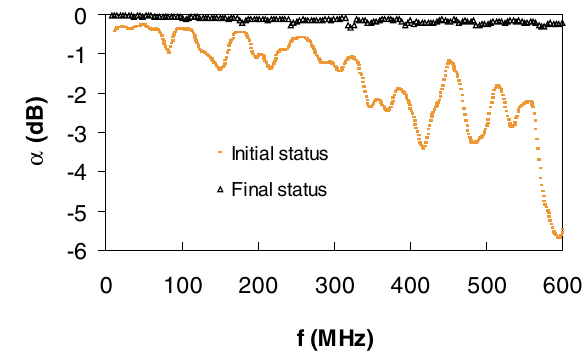
FIG. 6. (Color) Transmission coefficient of the TW chamber before (orange segments) and after (black triangles) the im- provements described in Sec. II. Finally, the transmission coefficient is within desired limits: (cid:4) 0 : 5 dB up to 600 MHz.